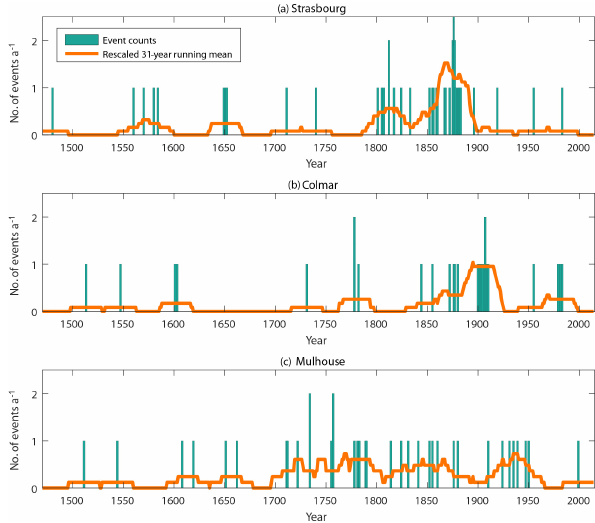
Figure 16. Chronologies for three specific